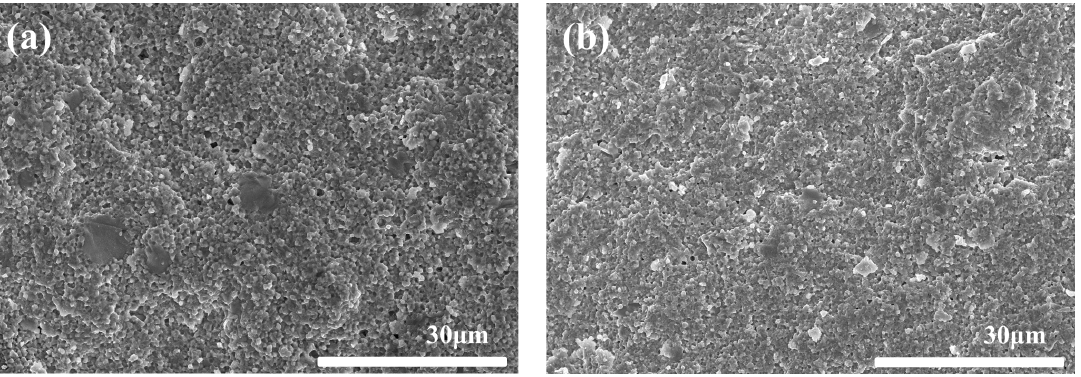
Figure 14. Comparison of fractural morphologies of the sintered parts at smaller magnification. ( a ) 1575 °C, and ( b ) 1550 °C.